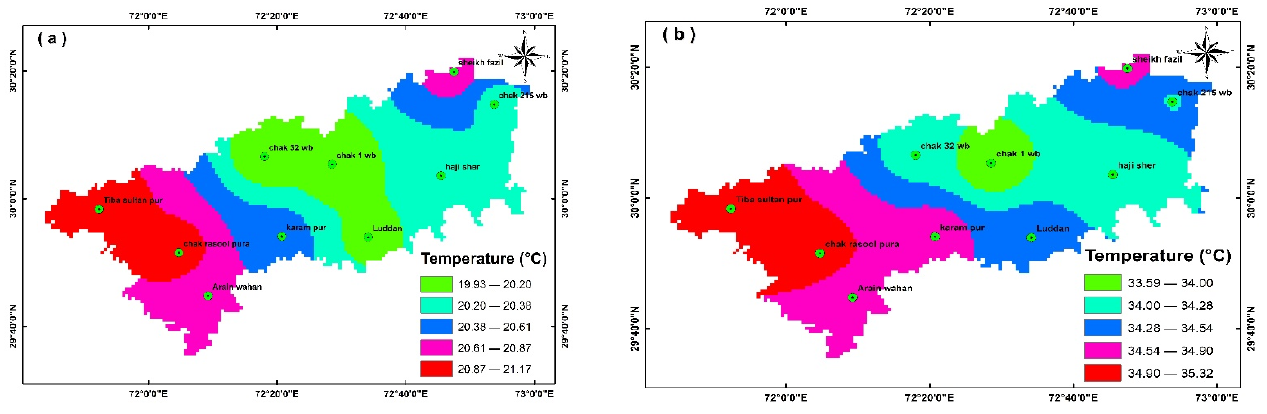
Figure 9. Mean NDVI seasonal changes for major crops during Kharif season ( a ) 1984, ( b ) 1993, ( c ) 2002, ( d ) 2011 and ( e ) 2020.